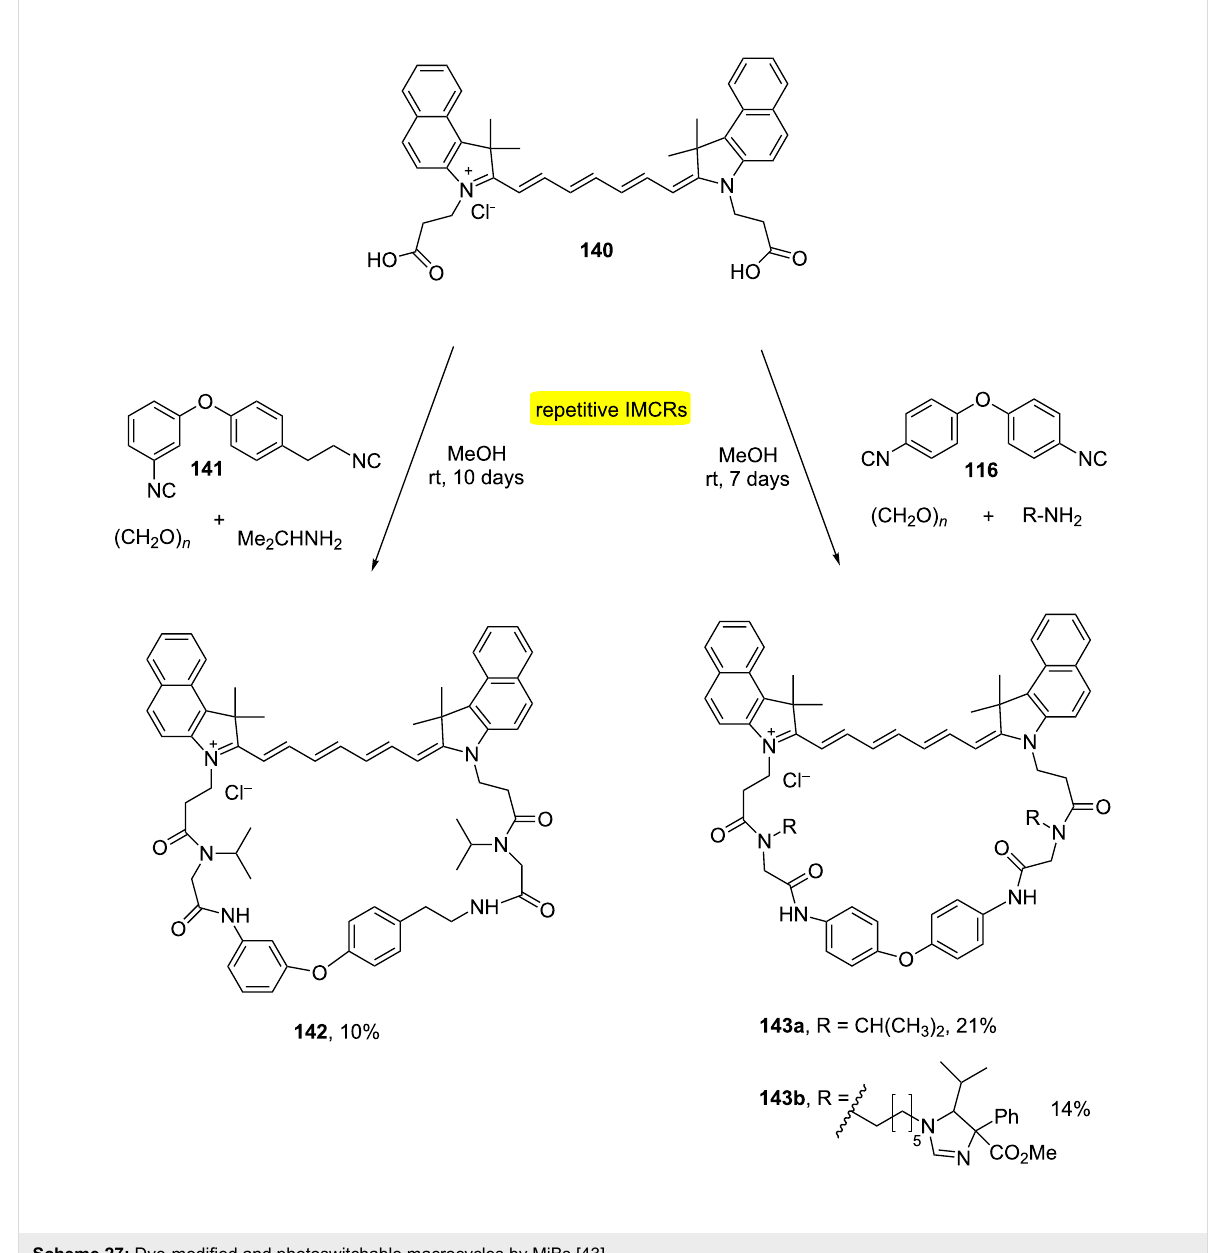
Scheme 27: Dye-modified and photoswitchable macrocycles by MiBs